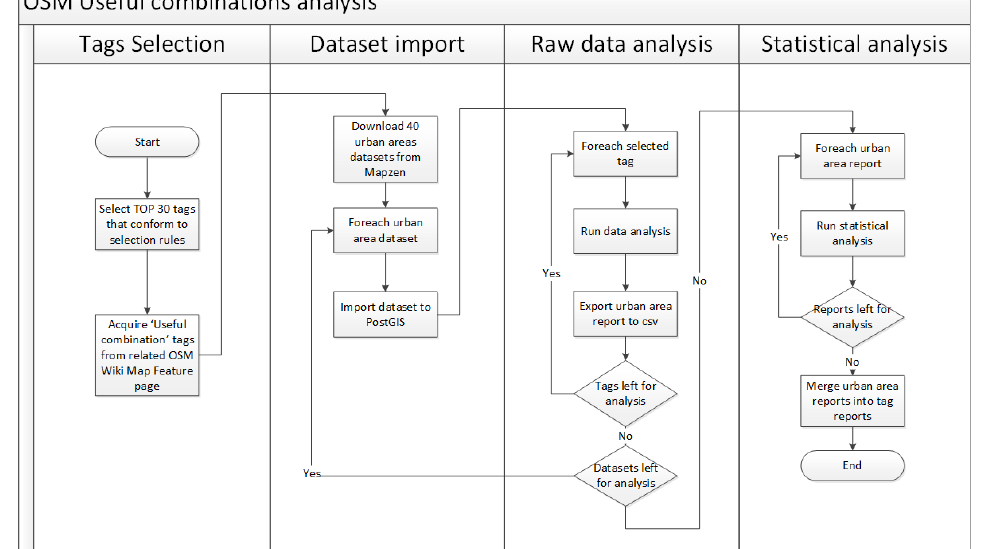
Figure 3. A flowchart of the methodology used to process the OpenStreetMap (OSM) data for candidate cities and urban areas for the selected